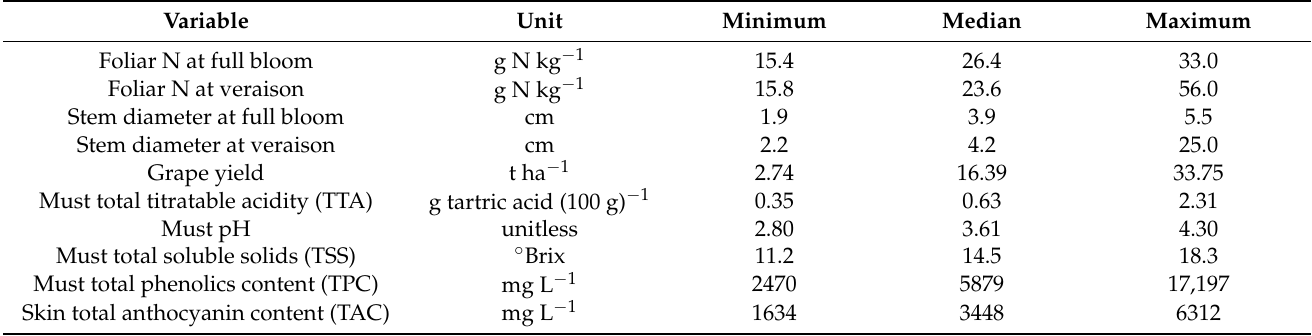
Table 2. The minimum, median, and maximum values of the features and target variables during the five experimental seasons.